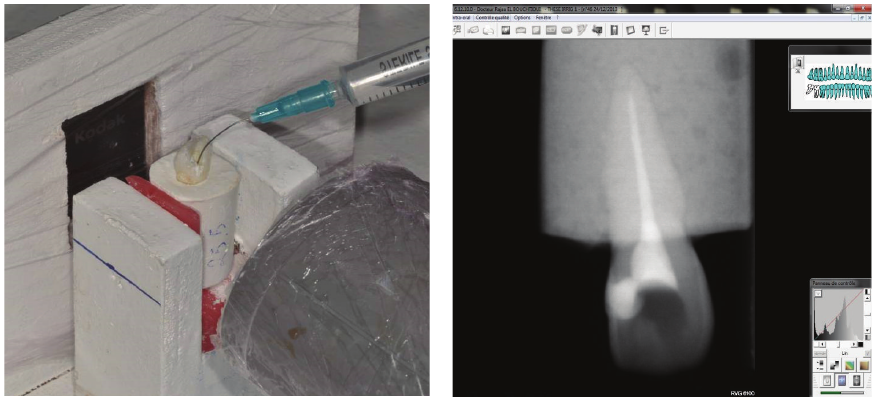
Figure 5: Irrigation with endodontic syringe.